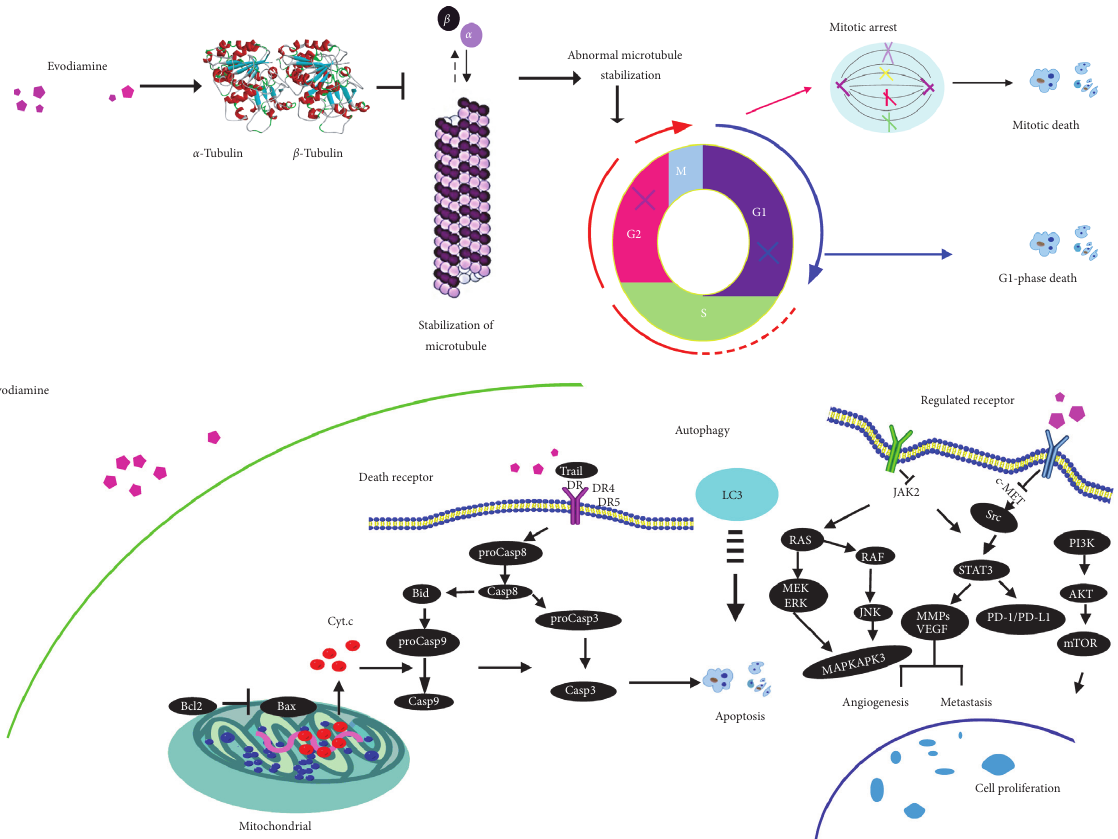
Figure 2: Probable molecular mechanisms by which evodiamine kills tumor